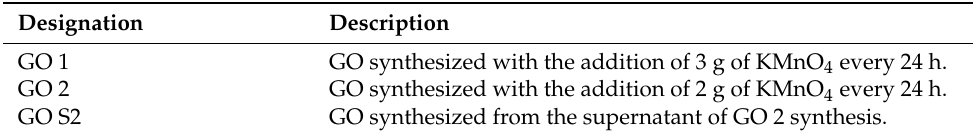
Table 1. Description of the GO samples